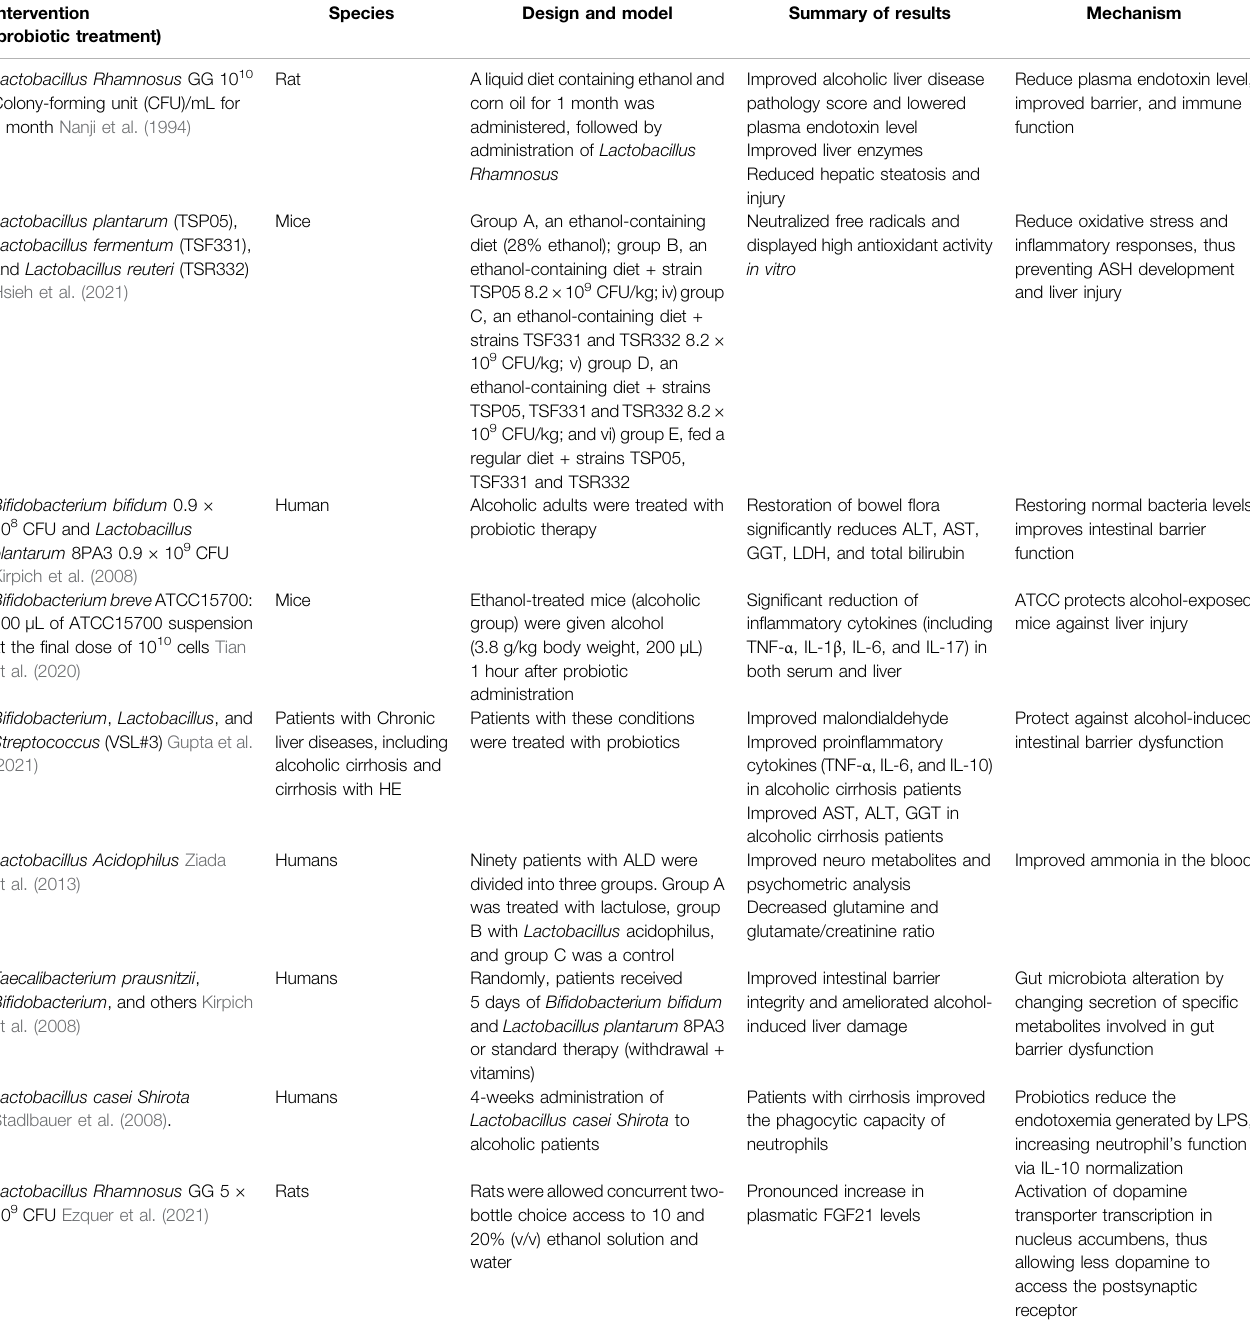
Species Design and model Summary of